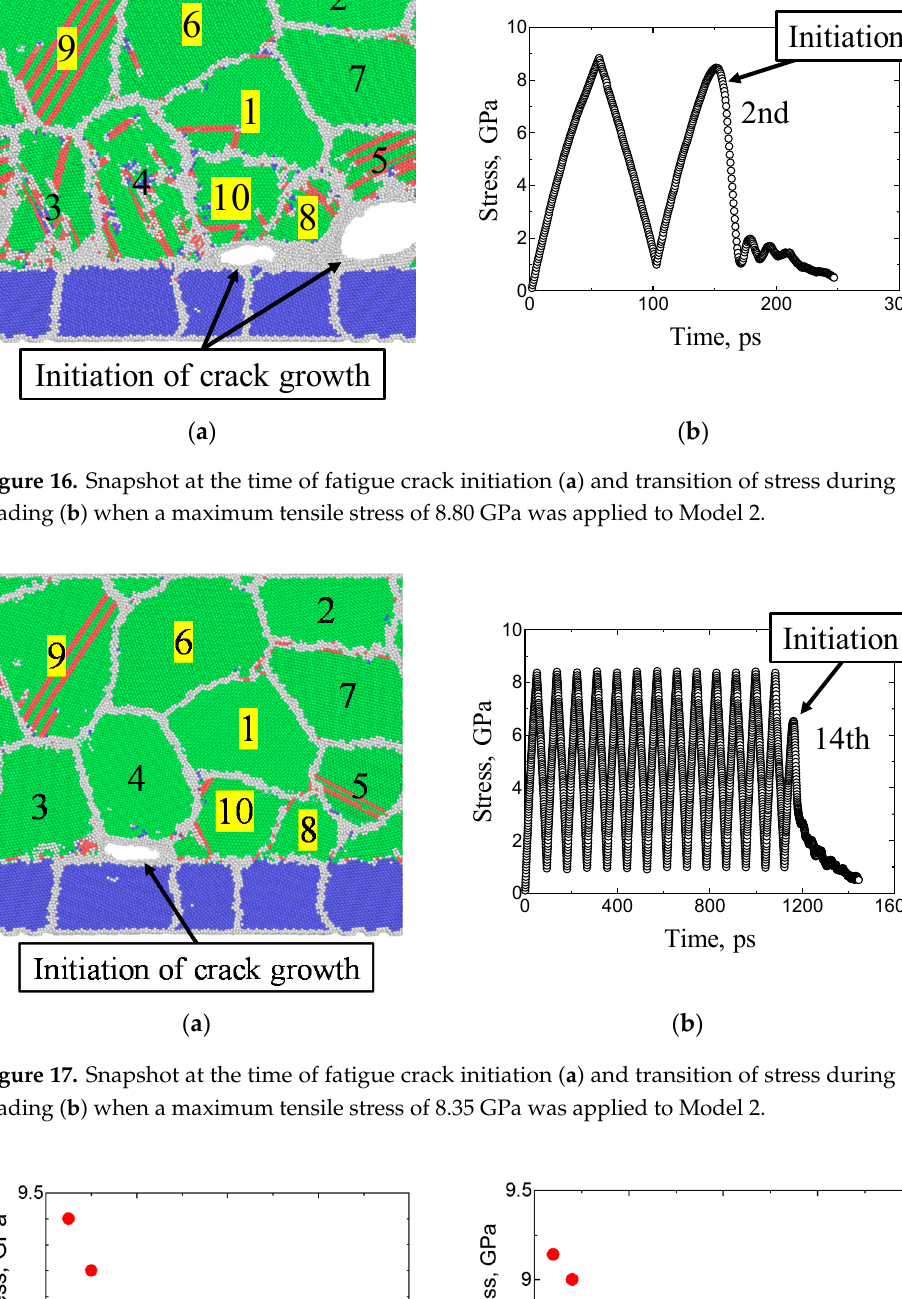
Figure 15. Snapshot at the time of fatigue crack initiation ( a ) and transition of stress during cyclic loading ( b ) when a maximum tensile stress of 8.80 GPa was applied to Model 1.